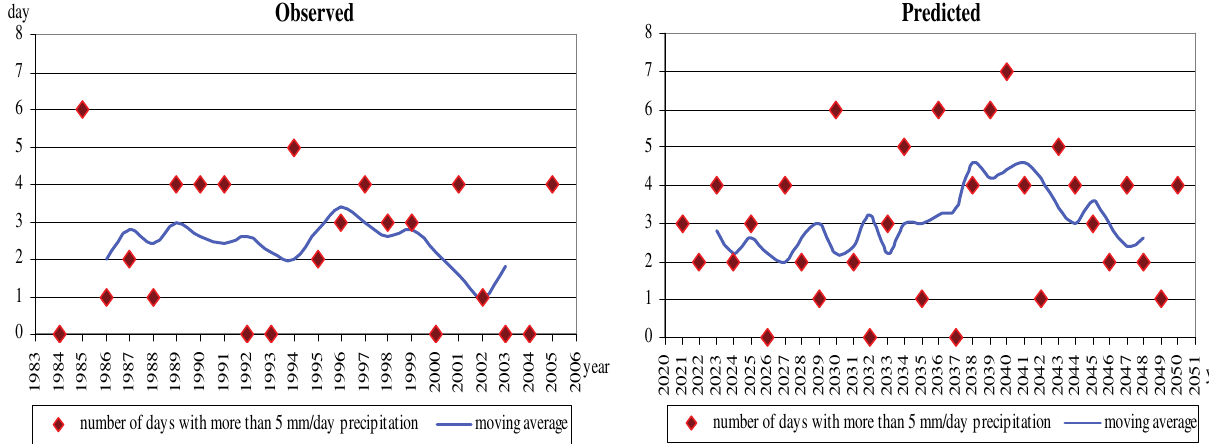
Figure 7: Number of days with more than 5 mm/day precipitation at Újfehértó as observed (Left) and estimated (Right) by the RegCM 3.1, for the 10 days + blooming period